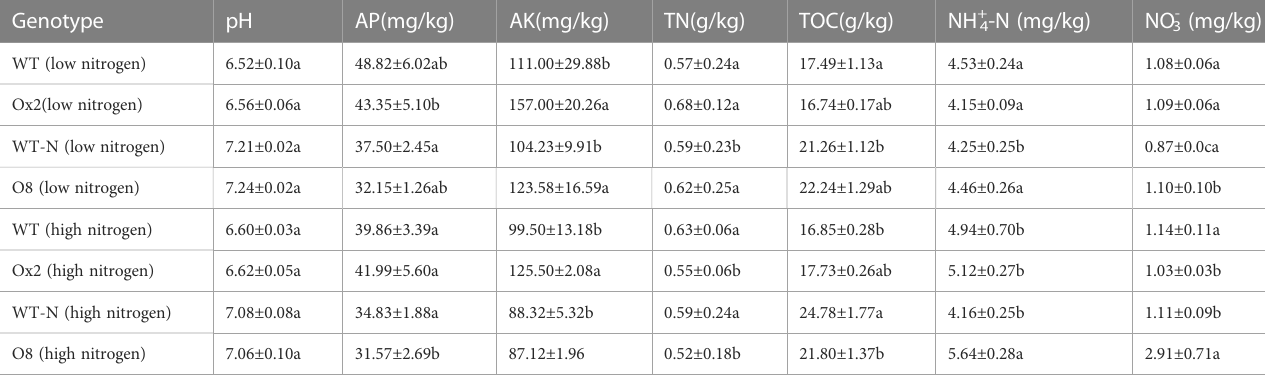
TABLE 1 The chemical characteristics i.e., pH, available phosphorus (AP) mg/kg, available potassium (AK) mg/kg, Total Nitrogen (TN) g/kg, Total organic carbon (TOC) g/kg, ammonium NH4+-N mg/kg and nitrate N0 3 N in mg/kg in low and high nitrogen application from the rhizosphere soil of the WT, Ox2, WT-N and O8 in the fi eld